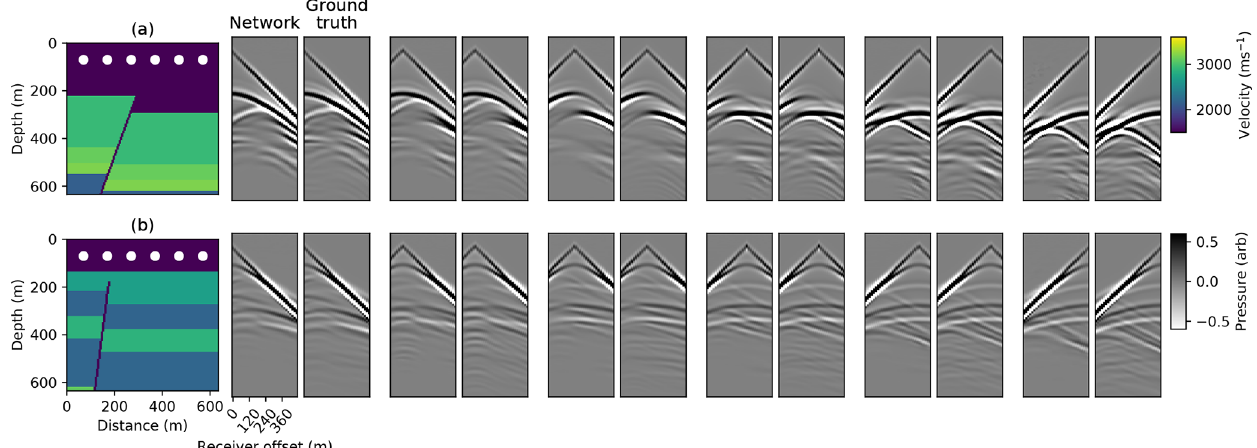
Figure 10. Conditional autoencoder simulation accuracy when varying the source location. The network simulation is shown for six different source locations whilst keeping the velocity model fixed. The source positions are regularly spaced across the surface of the velocity model (white circles). Example simulations for two different velocity models in the test set are shown, where each row corresponds to a different velocity model. The pairs of simulation plots in each row from left to right correspond to the network prediction (left in the pair) and the ground truth FD simulation (right in the pair), when varying the source location from left to right in the velocity model. A t 2 . 5 gain is applied for